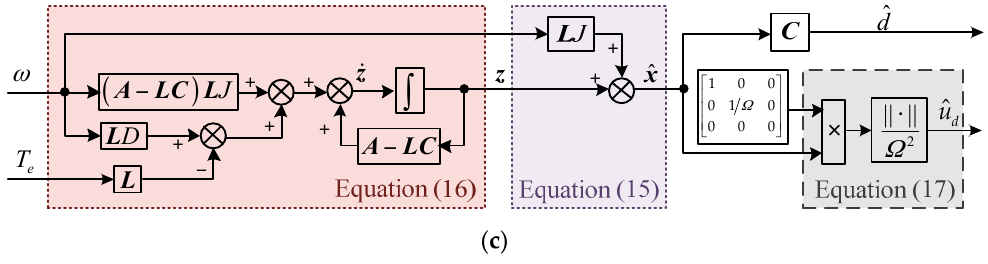
Figure 2. Design procedure of gimbal disturbance observer. ( a ) Observer design in theory; ( b ) observer with virtual measurement; ( c ) practical observer without the calculation of the differential .